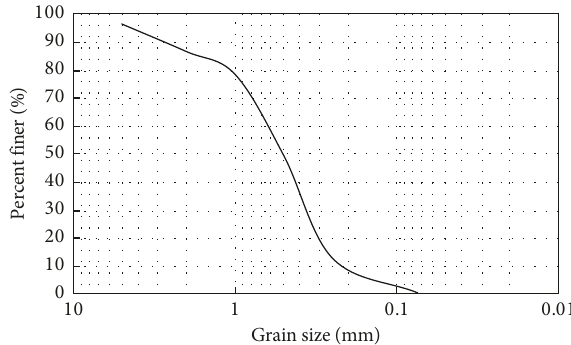
Figure 3: Grain size distribution of the